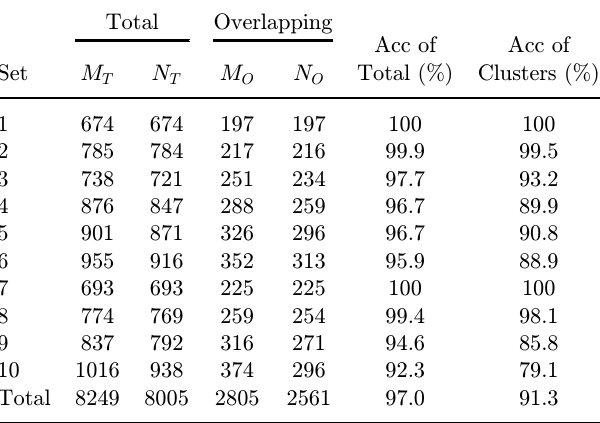
Table 1. Experiment results of the